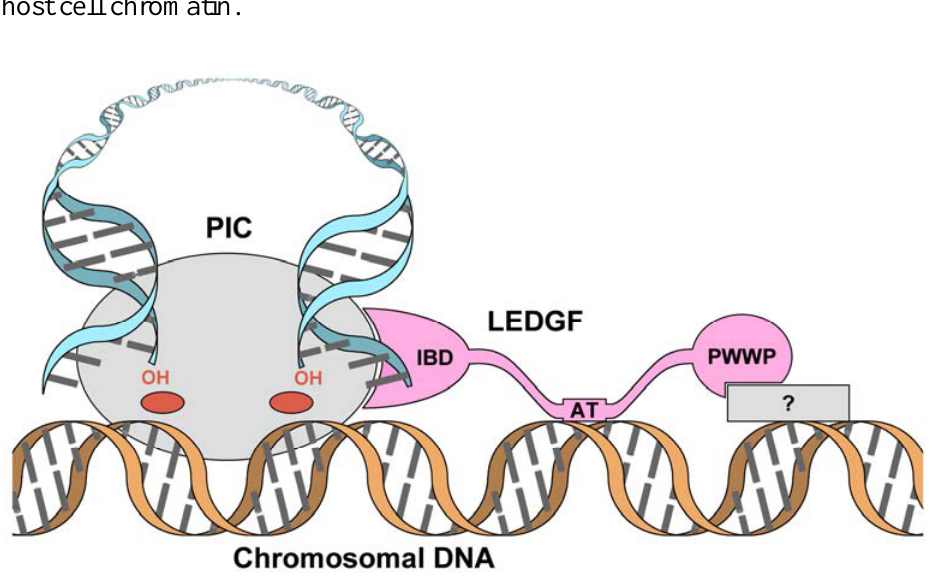
Figure 2. The role of LEDGF in lentiviral biology. Representations of IN and viral and host DNA are conserved from Figure 1. LEDGF (pink) interacts with the PIC via its C- terminal IBD, with host DNA via its AT-hooks and with an unidentified component of the chromatin (grey rectangle) via its N-terminal PWWP domain, tethering the PIC to select loci of host cell